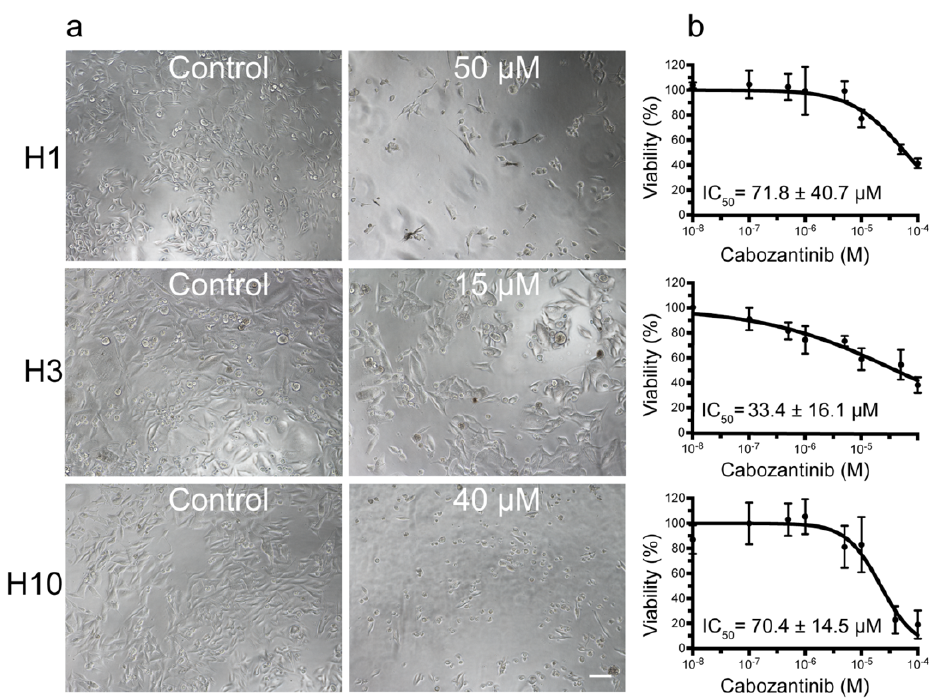
Figure 1. Cabozantinib decreases the viability of melanoma brain metastasis (MBM) cell lines in monolayer cultures. ( a ) Phase-contrast microscopic images (10 × objective) of cells grown as monolayers, either untreated (control) or treated with 50 μ M (H1), 15 μ M (H3) or 40 μ M (H10) cabozantinib for 72 h. Scale bar = 100 μ m. ( b ) Representative viability curves of cells grown as monolayers after treatment with cabozantinib with increasing concentrations. The cabozantinib concentrations at which the cell viability was reduced to 50% compared with the control (IC 50 ) were calculated from triplicate experiments.